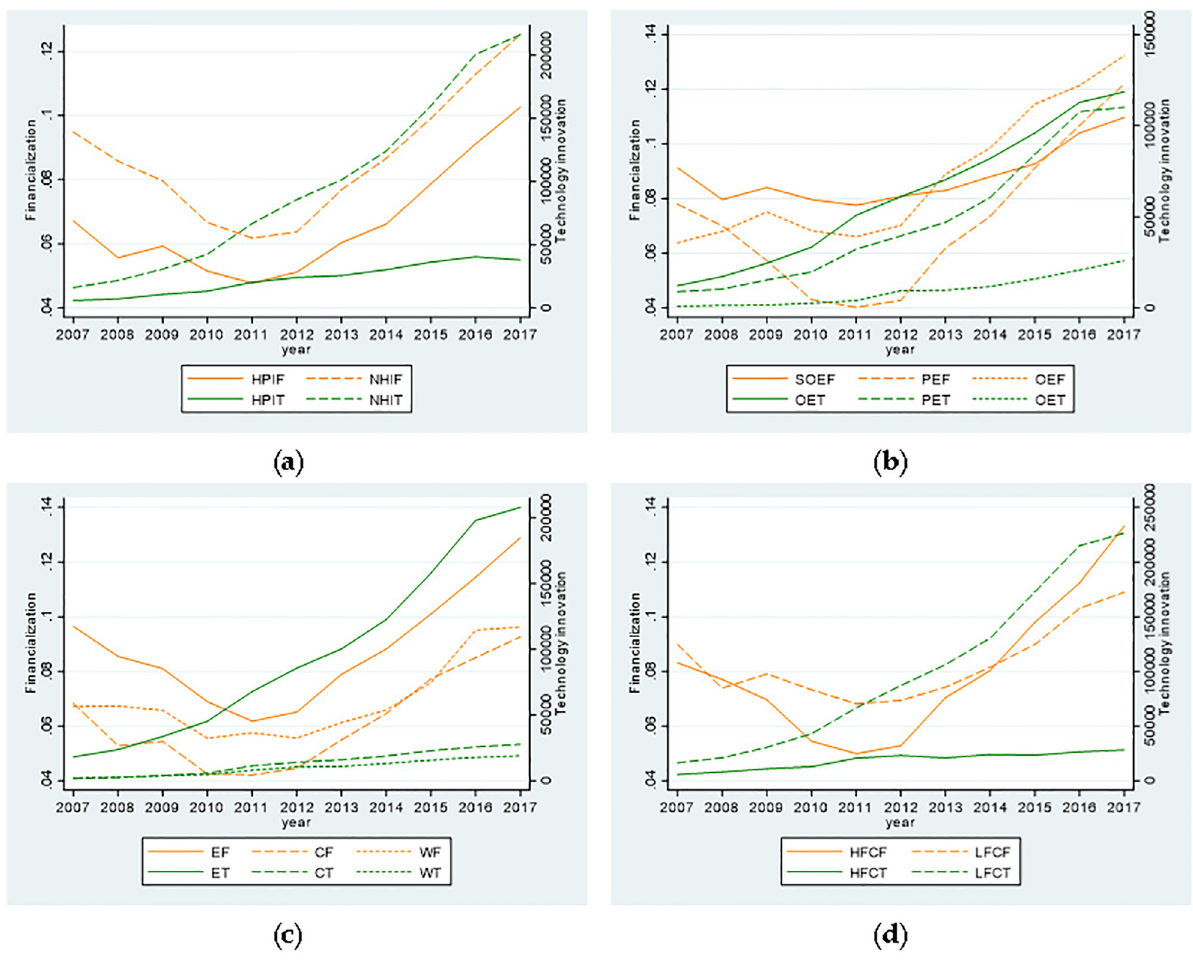
Fig 1. Line chart of the annual means of financialization degree, annual sums of technological innovation quantity and the years. Notes: (a) The line chart of industries with different pollution degrees. HPIF and NHIF represent the annual mean of the financialization degree of heavily polluting industries and non-heavily polluting industries, respectively. HPIT and NHIT represent the annual sum of the technological innovation quantity of heavily polluting industries and non-heavily polluting industries respectively. (b) The line chart of enterprises with different ownership. SOEF, PEF and OEF respectively represent the annual mean of financialization degree of state-owned enterprises, private enterprises and other enterprises; SOET, PET and OET respectively represent the annual sum of technological innovation quantity of state-owned enterprises, private enterprises and other enterprises. (c) The line chart of enterprises in different regions. EF, CF and WF represent the annual mean of financialization degree of enterprises in eastern, central and western regions, respectively. ET, CT and WT represent the annual sum of technological innovation quantity of enterprises in eastern, central and western regions, respectively. (d) The line chart of enterprises with different financing constraints. HFCF and LFCF represent the annual mean of financialization degree of enterprises with high and low financing constraints respectively, and HFCT and LFCT represent the annual sum of the number of technological innovation of enterprises with high and low financing constraints